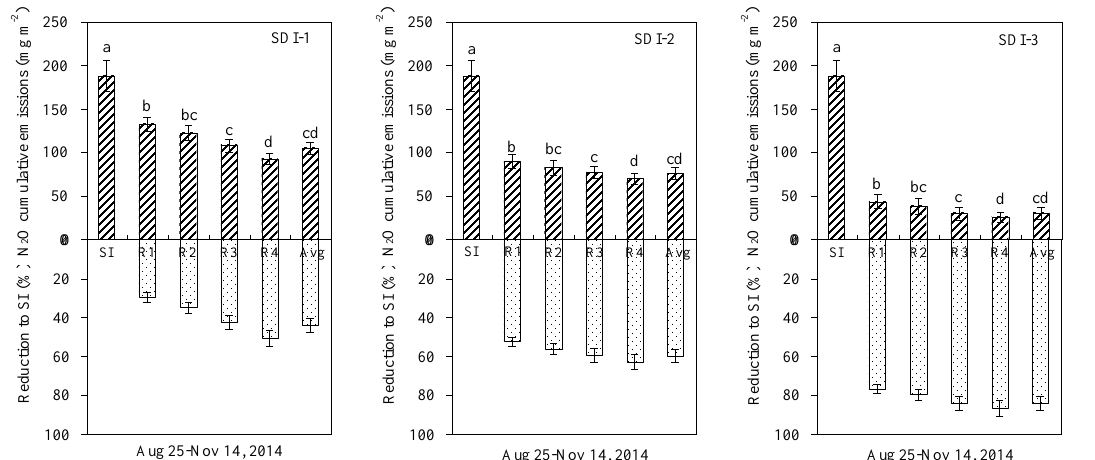
Figure 8. Cumulative N 2 O emissions in different sub-regions of SDI treatments and their reduction compared to SI treatment. ‘Avg’ represents area-weighted average value. Different letters on each bar represent significant differences in N 2 O cumulative emissions at p = 0.05 level.